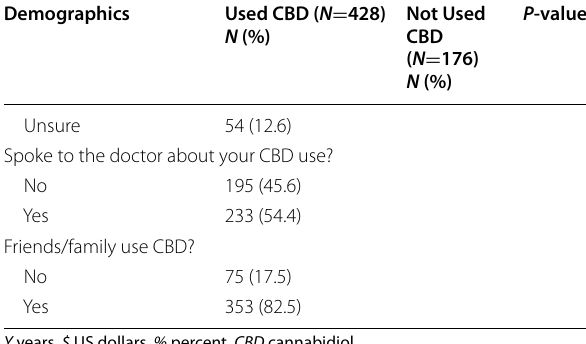
Table 1 Socioeconomic demographics of 604 survey participants with arthritis who use CBD and those who do not use